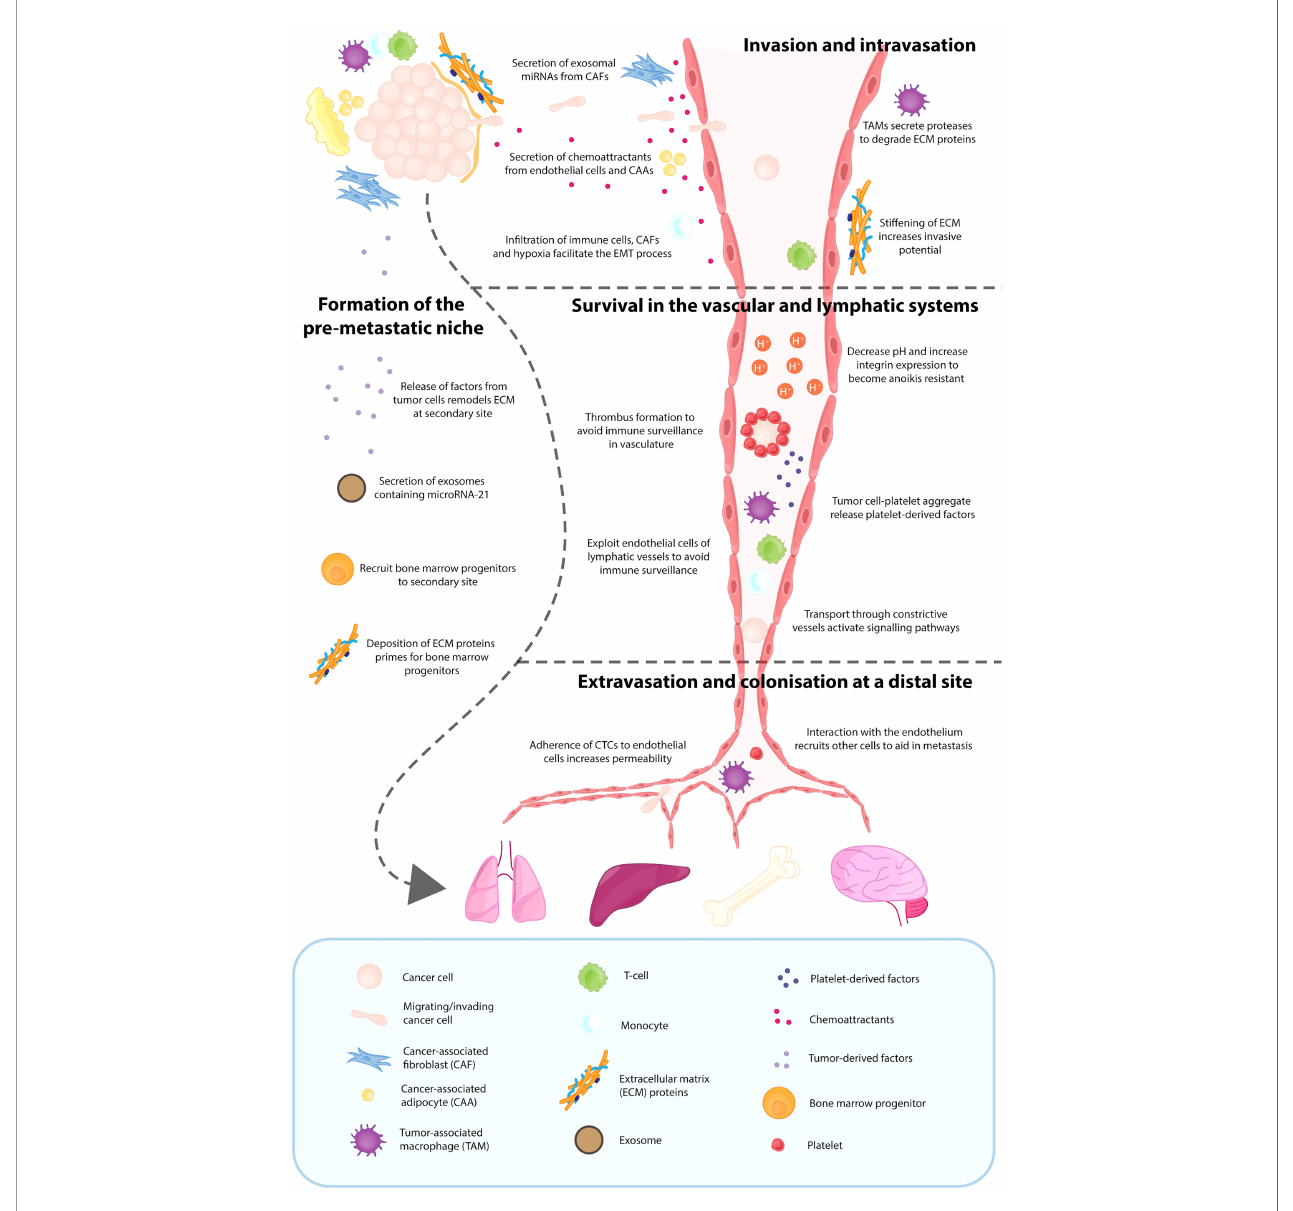
FIGURE 2 | Contribution of various tumor microenvironment components in the process of metastasis. Breast cancer metastasis relies on various components of the tumor microenvironment, with the major sites of metastasis being the lungs, liver, brain and bone. Even before breast cancer cells escape from the primary site, several factors and exosomes have been released into the circulation by the breast cancer cells, which results in deposition of extracellular matrix (ECM) proteins at the distal site and recruitment of bone marrow progenitors. This creates a favourable pre-metastatic niche (PMN), which is crucial for metastatic dissemination. The TME and PMN support breast cancer cells in the process of invasion and intravasation, survival in the lymphatic and vascular systems, and the eventual extravasation and successful colonisation. Once these CTCs have reached the distal organ, the formation of a metastatic niche is initiated, which supports the growth of the secondary